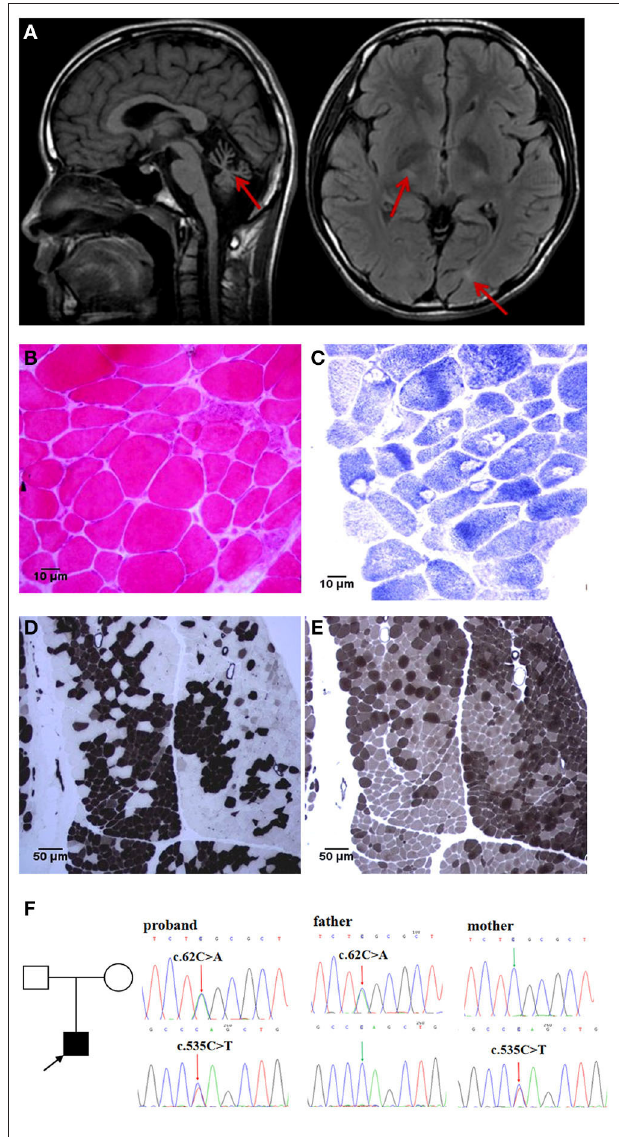
FIGURE 1 | Brain MRI, muscle histopathology, and genetic test findings: (A) Brain MRI reveals obvious cerebellar atrophy in T1WI (left), lateral ventricle posterior horn and basal ganglia white matter lesion in FLAIR (right, red arrows). (B–E) Skeletal muscle biopsy: HE staining [ (B) , 40 × objective] showed that the muscle fibers were significantly different in size, with atrophied angular fibers and enlarged round fibers. NADH staining [ (C) , 40 × objective] showed obvious atrophy of type I fibers, and more entomophagy occurred in type I than in type II fibers. ATPase staining showed obvious type I and type IIb fiber pathological compensatory hyperplasia, with deep staining spots in the muscle fibers of the histochemistry at pH4.3 [ (D) , 10 × objective] and pH10.4 [ (E) , 10 × objective]. (F) WES demonstrated a de novo compound heterozygous mutation of ADPRHL2 in proband, confirmed by Sanger sequencing of asymptomatic